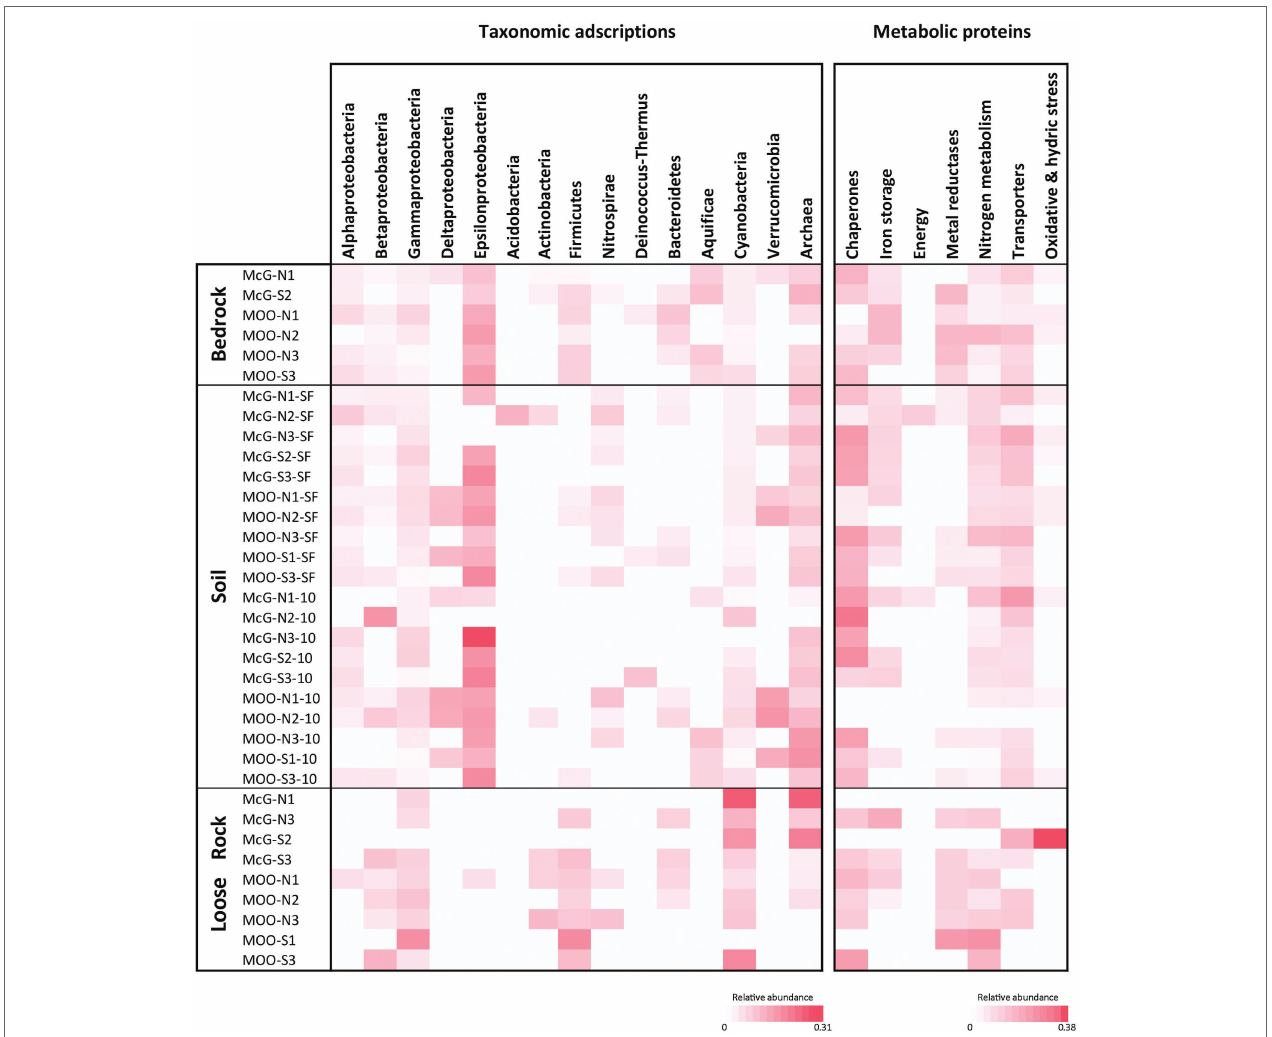
FIGURE 5 | LDChip results distribution heat maps of prokaryotic classes and microbial metabolism biomarkers among sampling points and substrates by means of LDChip analyses. The antibodies recognized by LDChip for microbial taxonomy – further information in Sanchez-Garcia et al. (2018) – were reorganized on the basis of the phylogeny of the targets. Average signal intensity corresponding to positive antibody reactions within each category was used as a proxy for relative abundance (note the different scale in relative abundance under each heat map). For both heat maps white color indicates non-detected signal, while intensity of positive signals is indicated from light pink (lower signal) to red (higher